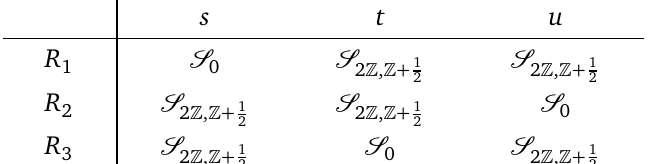
Table 5: Spectrums of R